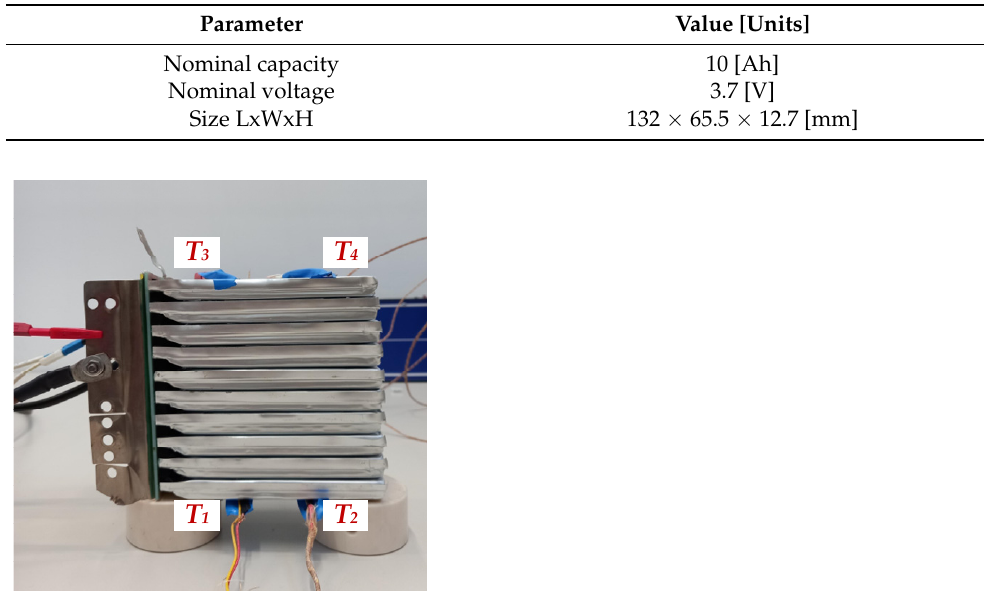
Table 1. Battery cell specification.